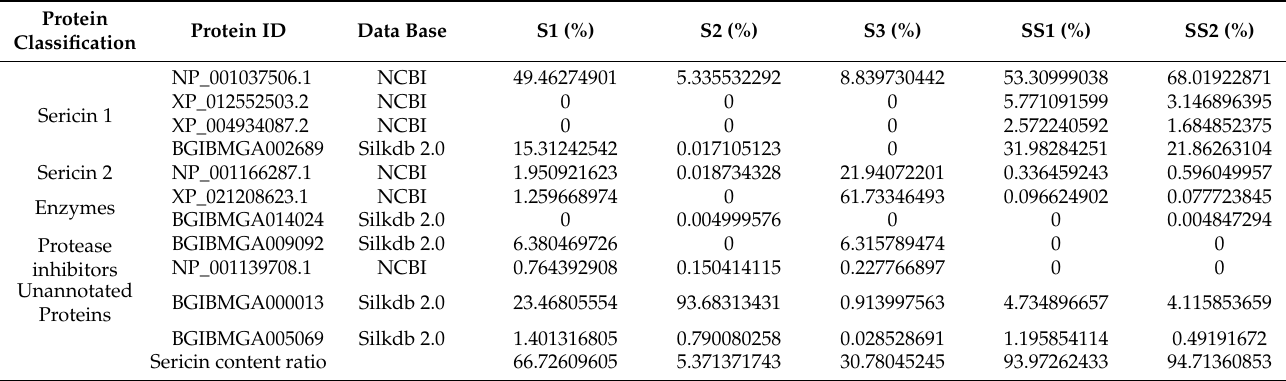
Table 2. The proteins identified by